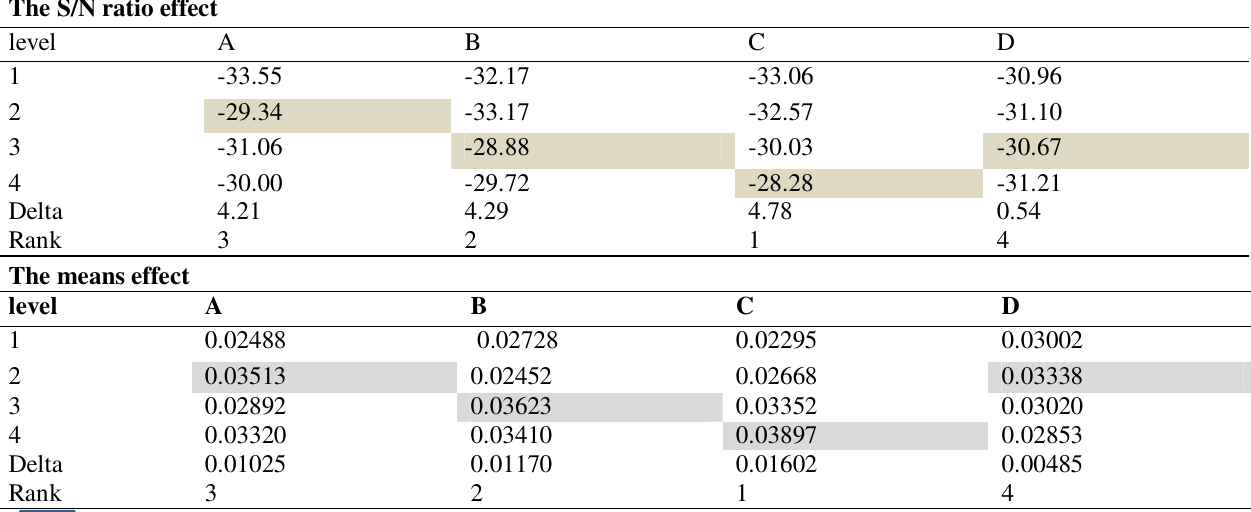
Table 5, The effect of the (S/N) ratio and mean of MRR stainless steel 304 .